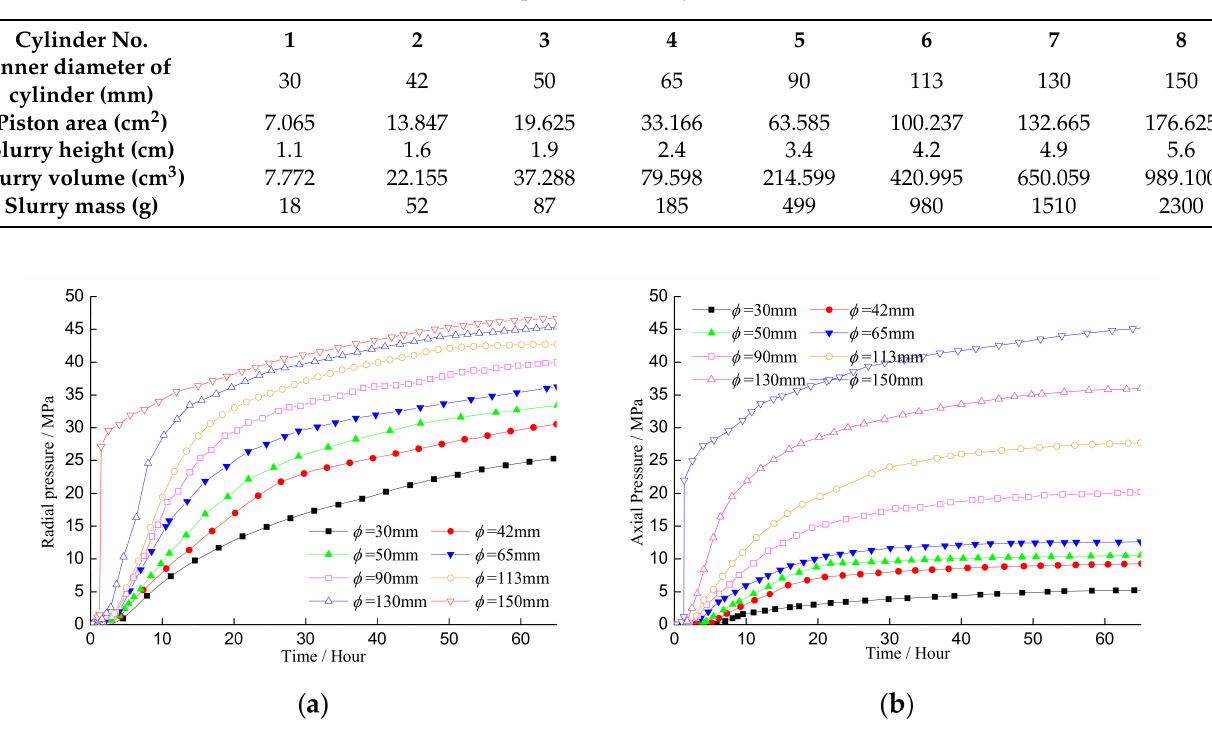
Figure 2. Time histories of radial and axial expansive pressures obtained by experiments: ( a ) radial expansive pressure, ( b ) axial expansive